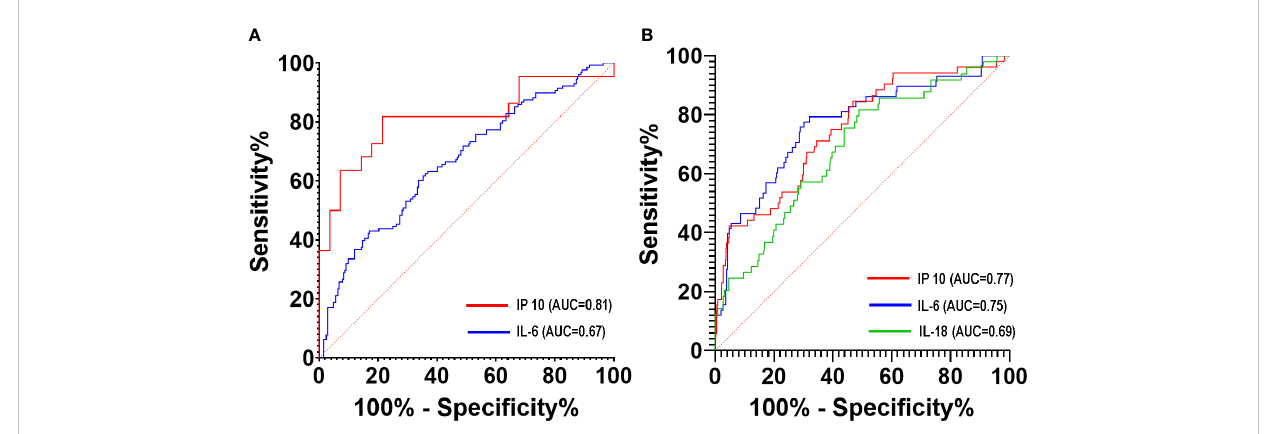
FIGURE 5 ROC curves of serum cytokine levels to predict disease progression (A) and mortality (B) of COVID-19 patients during